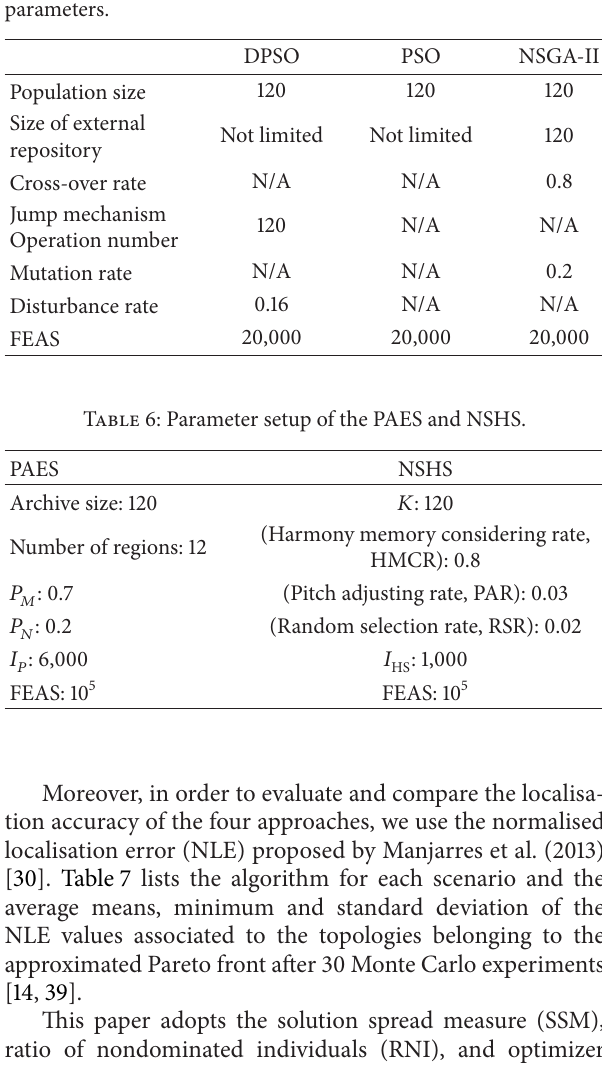
Table 5: Settings of different multiobjective optimisation algorithm